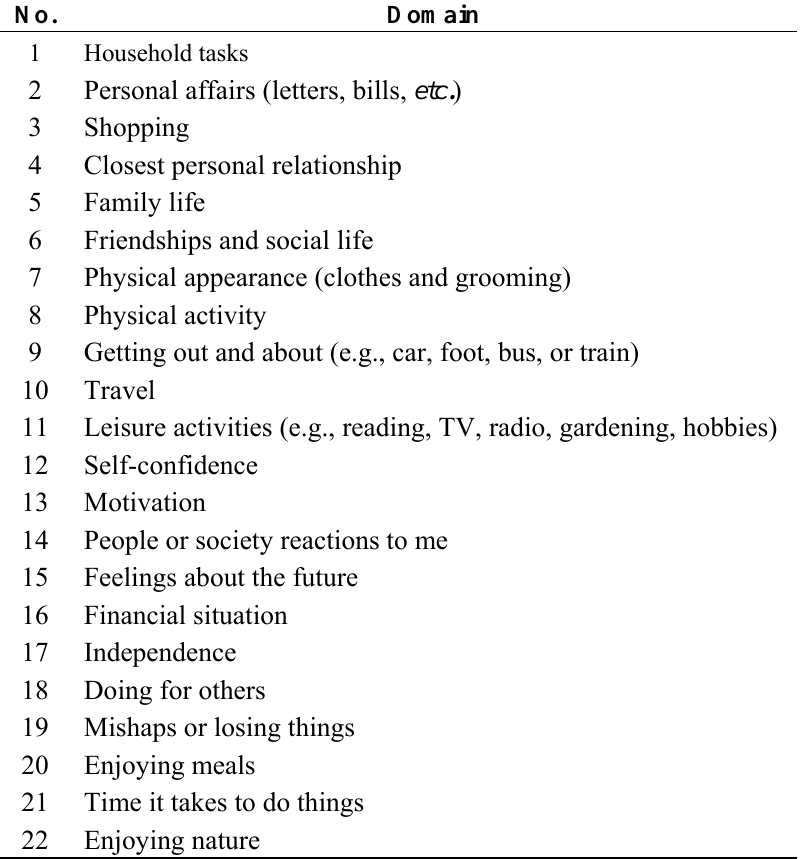
Table 1. Macular degeneration on quality of life (MacDQoL) domain-specific items.